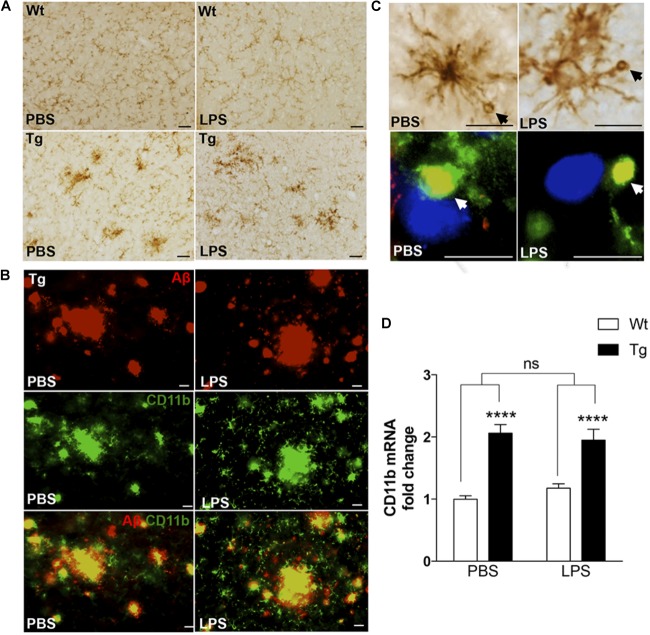
CD11b+ cells clustering around Aβ plaques display Aβ-containing vacuole-like structures. (A) IHC staining showing CD11b+ cells in the neocortex of PBS- and LPS-injected Tg and Wt mice. Cells with altered morphology and with some forming clusters are more abundant in Tg mice compared to Wt mice. (B) Double immunofluorescence staining showing co-localization (yellow) of 6E10+ Aβ plaques (red) and CD11b+ cells (green) in both PBS- and LPS-injected Tg mice. (C) CD11b+ cells with vacuole-like structures are observed in both PBS- and LPS-injected Tg mice, and double immunofluorescence shows some vacuoles to be Aβ+ (yellow). (D) Quantitative PCR analysis showing a significant effect of genotype, and no effect of LPS administration, on the CD11b mRNA levels. Two-way ANOVA followed by Tukey’s multiple comparisons test. Bars and error bars represent mean ± SEM, n = 7–10 per group, ∗∗∗∗p < 0.0001. Scale bars: 25 μm (A), 20 μm (B), 50 μm (C, top), and 10 μm (bottom).